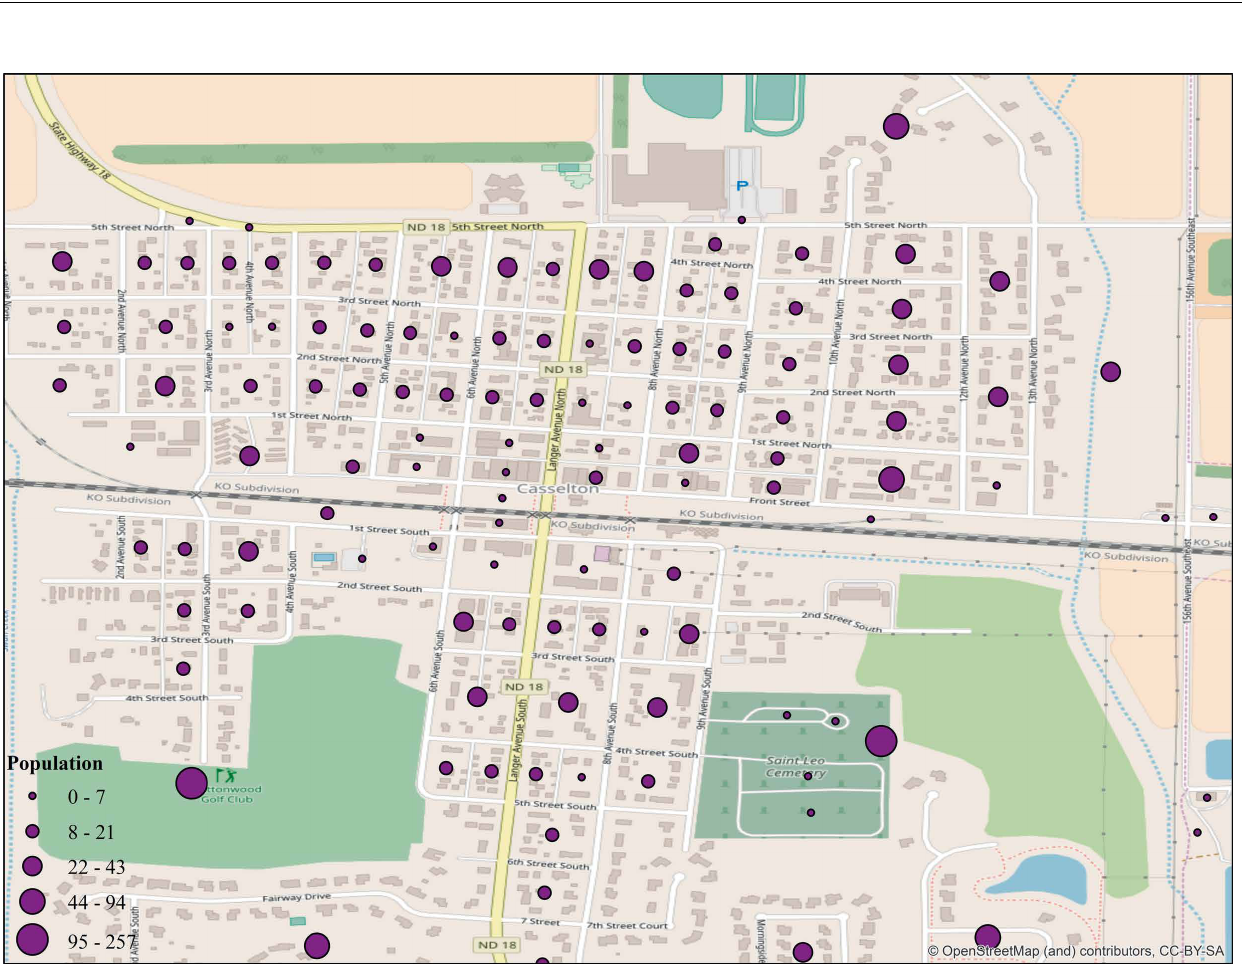
Figure 4: The geography, transportation network, and population of Casselton, ND